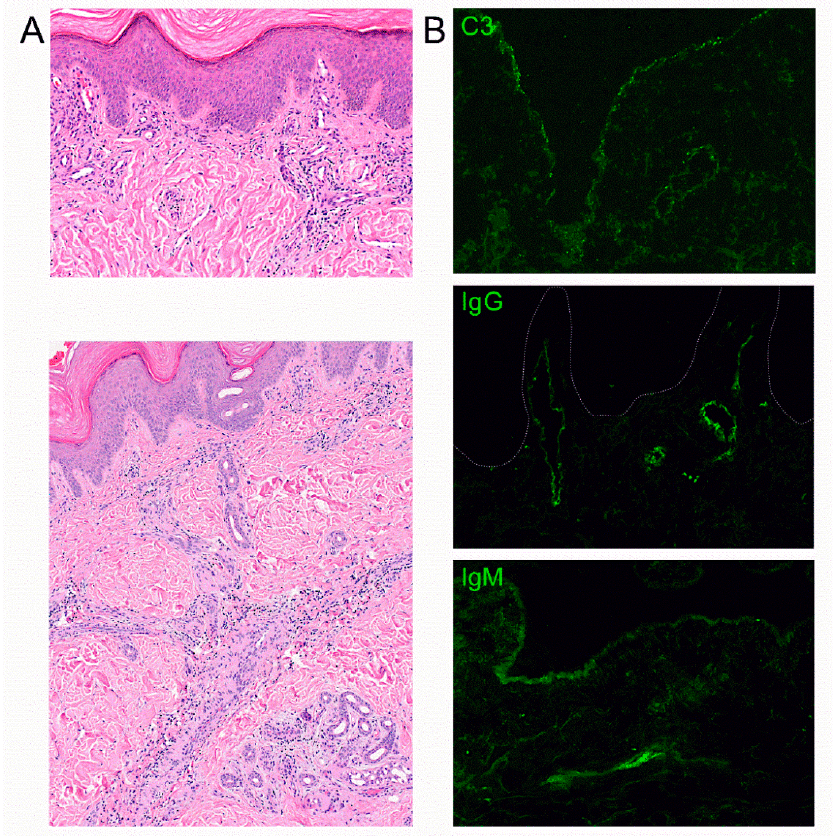
Figure 2. Histological pattern of chilblain-like lesions. Hematoxylin Eosin (HE) staining of chilblain-like lesions demonstrating superficial and deep perivascular and periadnexal lymphocytic infiltrates ( A ), magnification ×200 and ×100. Immunofluorescence staining shows deposition of c3, IgG and IgM in dermal vessels and granular c3 and IgM deposits at the basement membrane zone ( B ), magnification ×400. Histology of Patient 2 is shown as representative of similar results in all three patients.